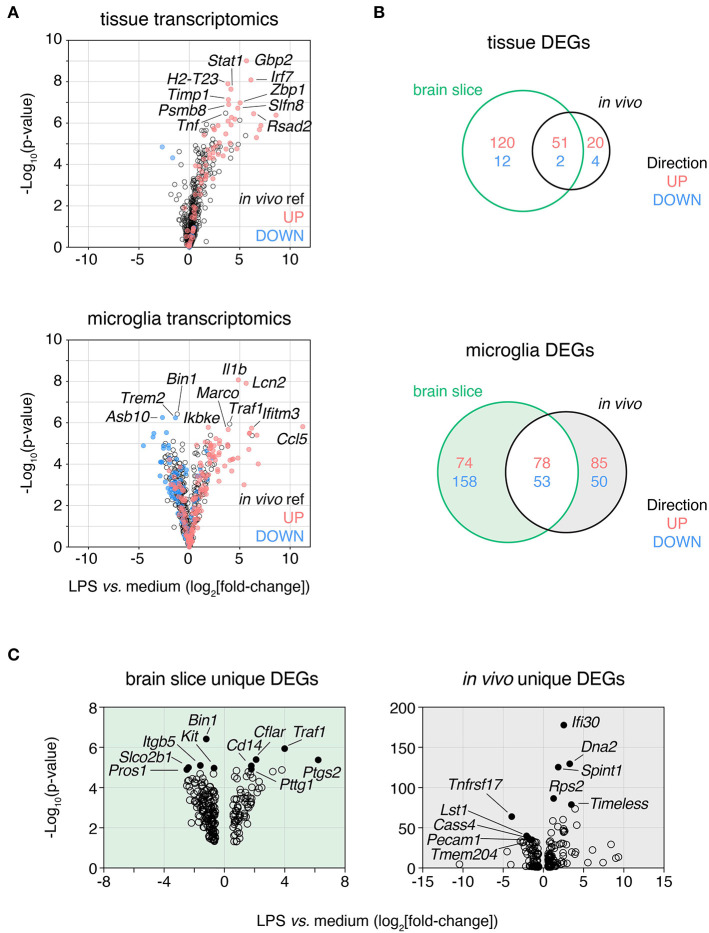
LPS response in brain slices is consistent with in vivo response both at a tissue level and in isolated microglia. Slices were treated with lipopolysaccharide (LPS, 100 ng/mL) for 24 h and either whole tissue or FACS-isolated microglia were harvested and subjected to expression profiling across a panel of neuroinflammatory genes (NanoString nCounter Neuroinflammation panel). These data were compared to analogous in vivo LPS response RNAseq data derived from either brain tissue or isolated microglia. (A) Whole slice (top) and FACS-isolated slice microglia (bottom) LPS response represented as volcano plots (all genes) with up- and down-regulated genes in in vivo LPS reference datasets displayed in red and blue, respectively. Top 10 DEGs ranked by p-value labeled. (B) Venn diagram of LPS-induced DEGs identified at the tissue-level (top) or microglia-level (bottom) after LPS treatment in brain slices or in vivo. (C) Volcano plots of DEGs unique to either brain slice microglia or in vivo microglia (as indicated by shading in B). Top five most significantly DE up- and down-regulated genes for each are labeled and indicated in closed circles. n = 4 whole slice samples per group; n = 3 samples per group for isolated slice microglia (three slices were pooled prior to sorting for each sample). n = 4 samples/group from independent mice for LPS in vivo reference data. LPS DEGs identified based on absolute fold-change > 1.5 and adj. p-value < 0.05. Reference in vivo DEGs not included in the NanoString nCounter Neuroinflammation panel are not shown. See also Supplementary Table 2.